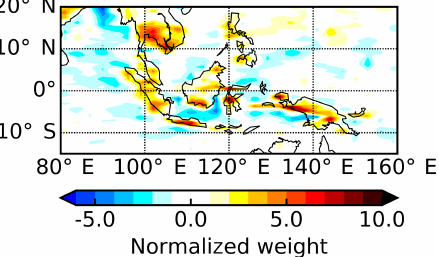
Figure 3. A zoom-in of Fig. 1b showing the second empirical or- thogonal function over the Maritime Continent region bounded by 15 ◦ S–20 ◦ N and 80–160 ◦